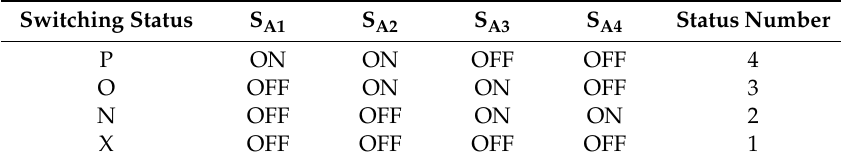
Table 1. T-npc Converter switching status.